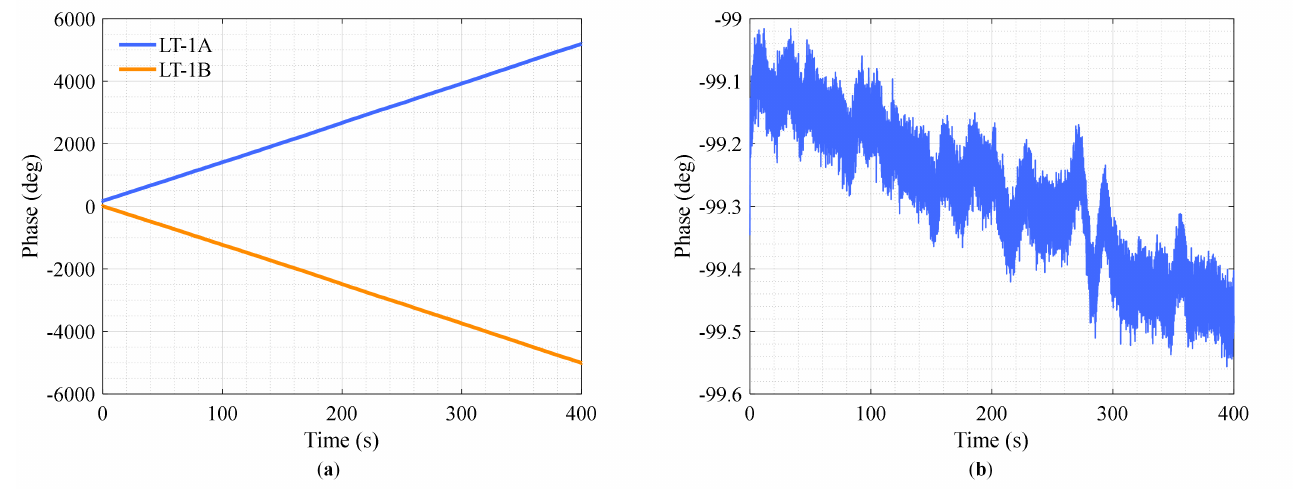
Figure 6. ( a ) Synchronization phase of LT-1A ϕ ba and LT-1B ϕ ab . ( b ) Internal calibration compensation phase ϕ cal .